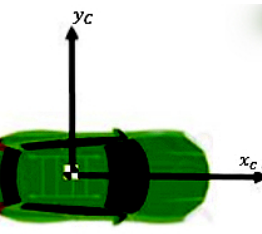
Figure 3. The car frame coordinate system. x c denotes the direction of driving, and y c indicates the side direction of the